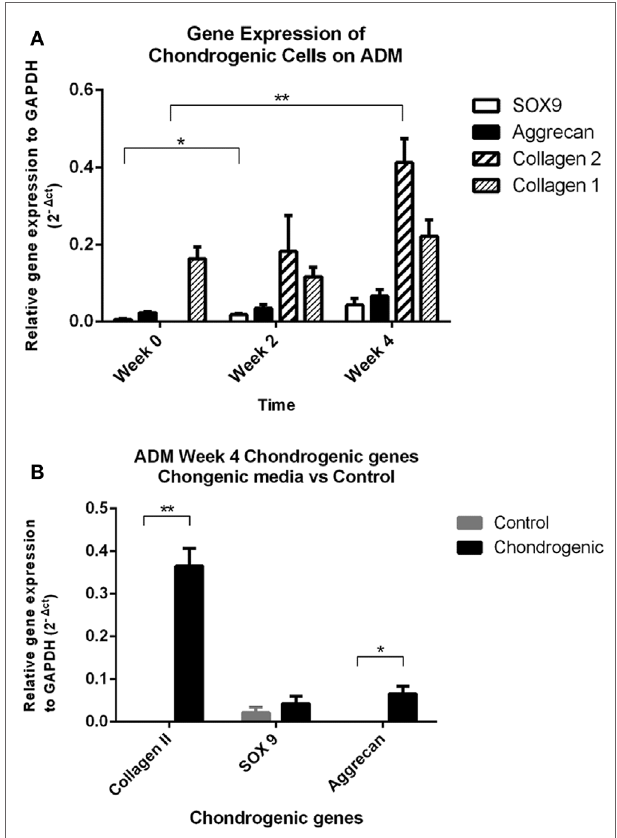
FigUre 5 | Quantitative Pcr results. (a) Real time qPCR data comparing changes in mRNA gene expression (relative to GAPDH housekeeping gene) in the chondrogenic group showed significant increases in collagen Type II and SOX9 gene expression over the 4-week period. Collagen Type I was expressed by the cells (day 0), and levels remained unchanged over the 4 week period. ** p < 0.005 Friedman’s test, * p < 0.05 t -test. (B) Real-time qPCR data comparing gene expression relative to GAPDH between the chondrogenic group and control group at the 4-week time point. Both collagen Type II and aggrecan gene expressions were significantly increased by week 4 in the chondrogenic group compared to the control group. Collagen Type II gene expression was undetectable in the control group at week 4. ** p < 0.005 Friedman’s test, * p < 0.05 t